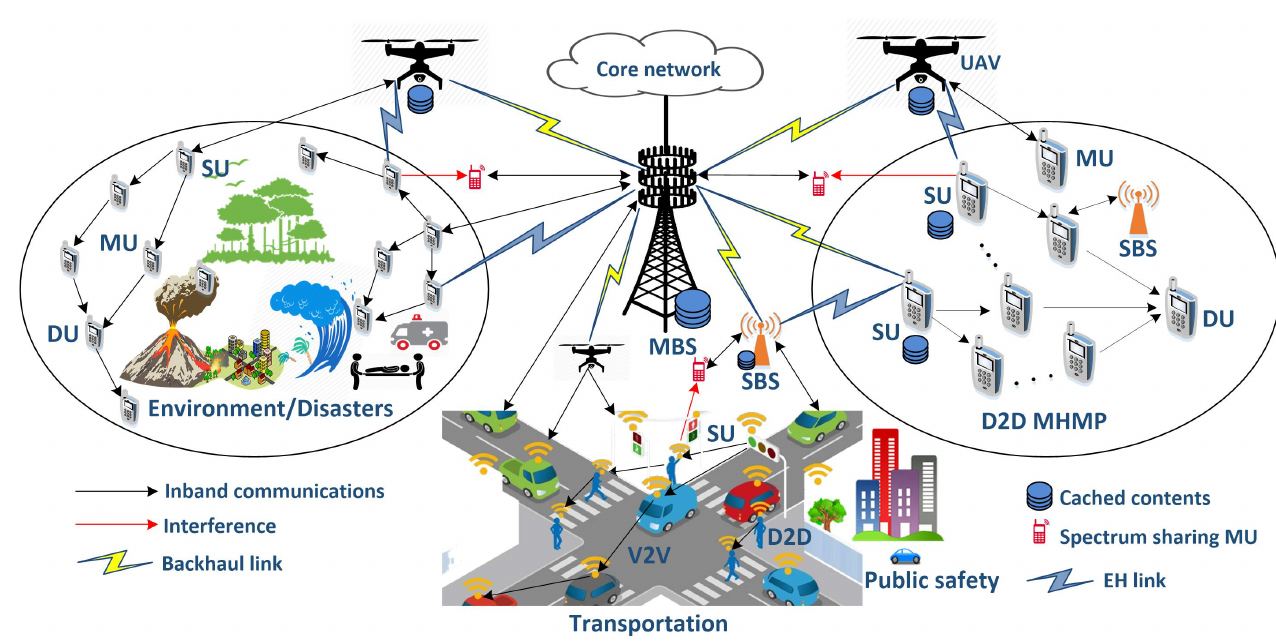
Figure 2. A Typical Architecture of D2D MHMP